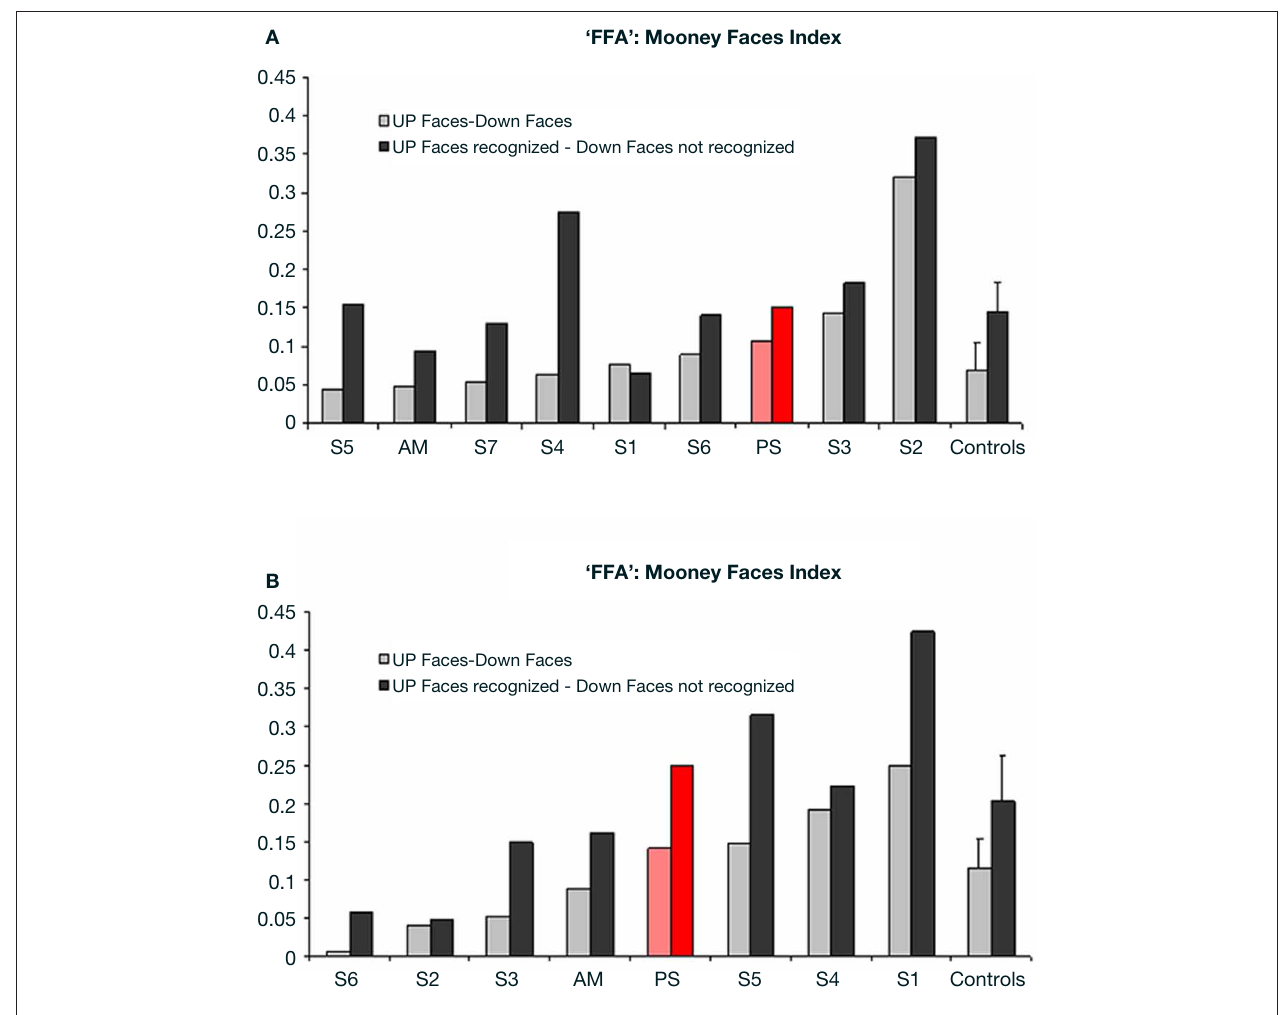
including PS and the age-matched control. Note that the difference was larger when only the trials that were correctly categorized as faces or non-faces were considered in the analysis. (B) Indexes of the level of differential activation for face and non-face stimuli in the experiment 2 with Arcimboldo